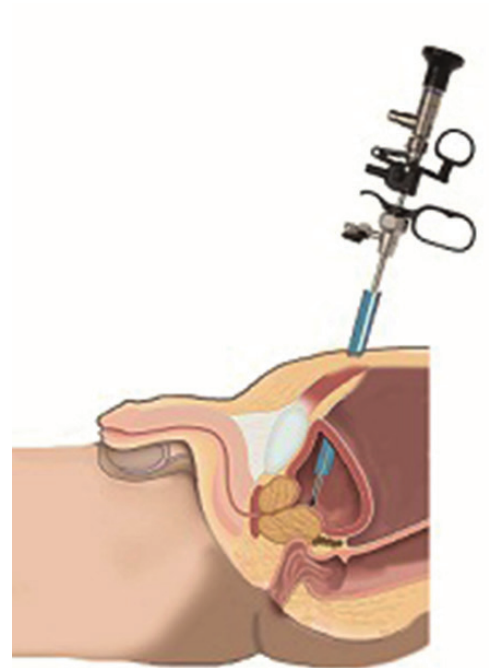
figure 1 - percutaneous puncture of the bladder and placement of the renal sheath and